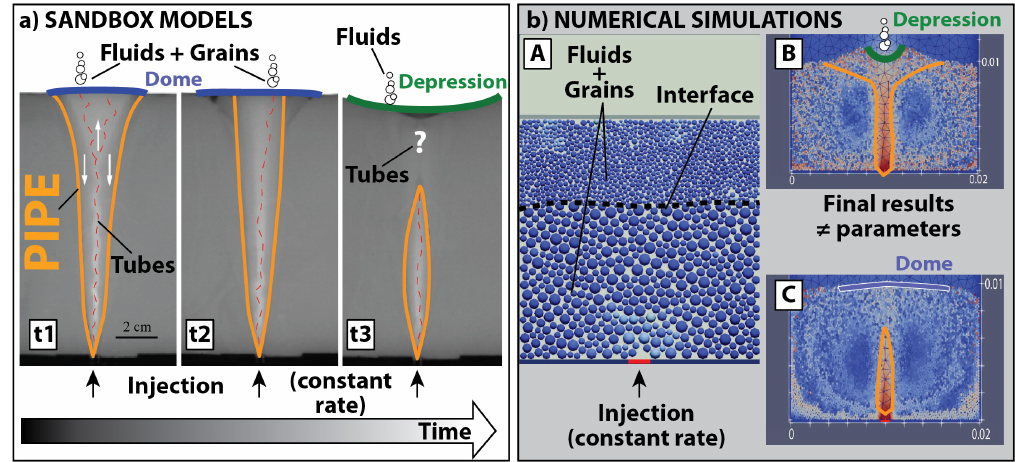
Figure 4: (a) Fluidized zone formed by water injected at constant flow-rate ( Q =50 mL/min) at the base of a granular layer (glass beads 106-212 µ m) immersed in water. t 1 , t 2 , t 3 indicate successive times ( t 3 (cid:39) 2 . 5 h). At short times ( t 1 ), the lower part of the fluidized zone is a vertical narrow zone while the upper part is wider, analogous to the stem and corolla described in section II.i. (b) (A) Modeling an interface between coarse (bottom) and fine (top) grains. (B) Full fluidization or (C) formation of a cavity for an initially homogeneous granular layer immersed under water (5000 particles, radius 200 µ m, cell dimensions indicated in m, 25 s simulations). The water injection velocity through the central bottom point is (B) v = 2 × 10 − 2 m/s and (C) v = 1 . 5 × 10 − 2